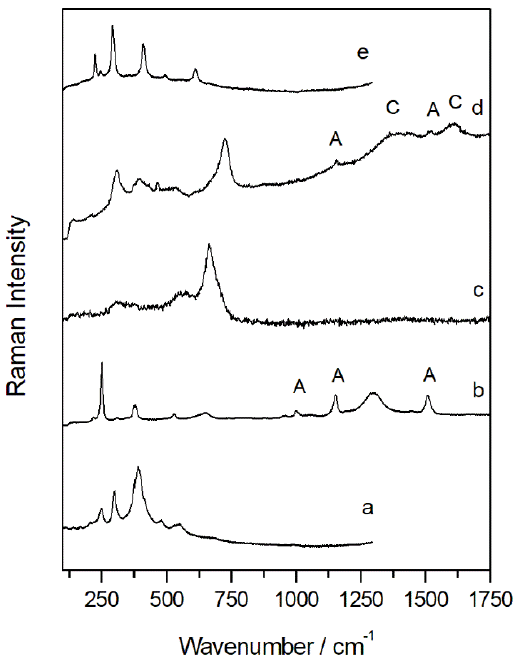
Figure 8. Raman spectra of goethite ( a ), lepidocrocite plus astaxanthin (A) ( b ), magnetite ( c ), akaganeite with traces of astaxanthin (A) and carbon (C) ( d ), and hematite ( e ) from the sample SUBS-4b.